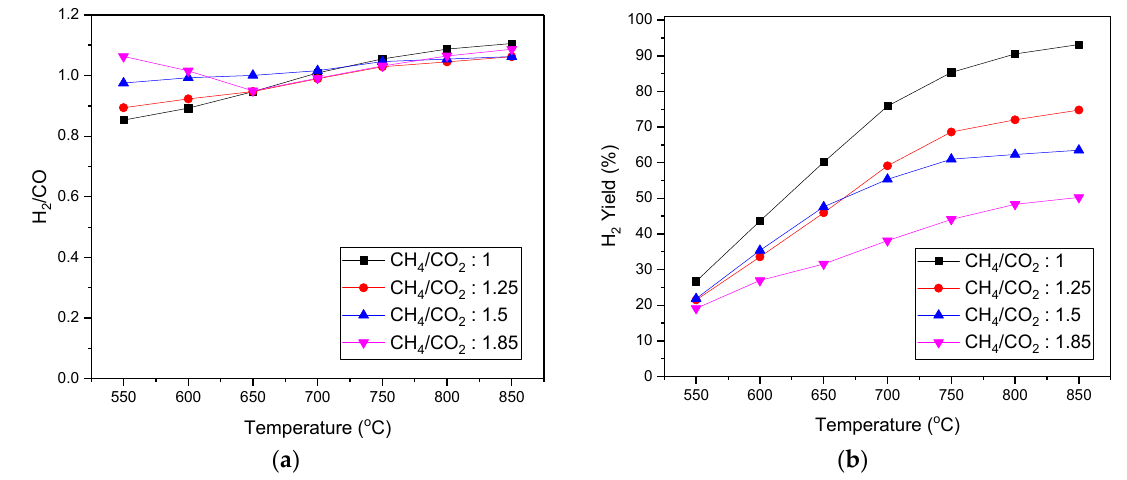
Figure 6. ( a ) H 2 /CO ratio and ( b ) H 2 yield for Ni-Sn/CeAl at CH 4 /CO 2 molar ratios of 1, 1.25, 1.5 and 1.85 as a function of temperature.